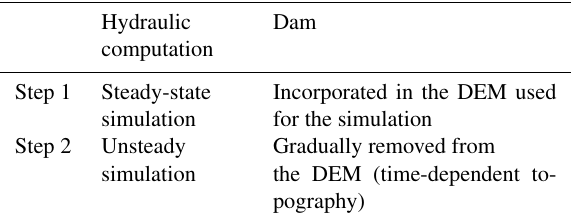
Table 3. Two-step hydraulic modelling